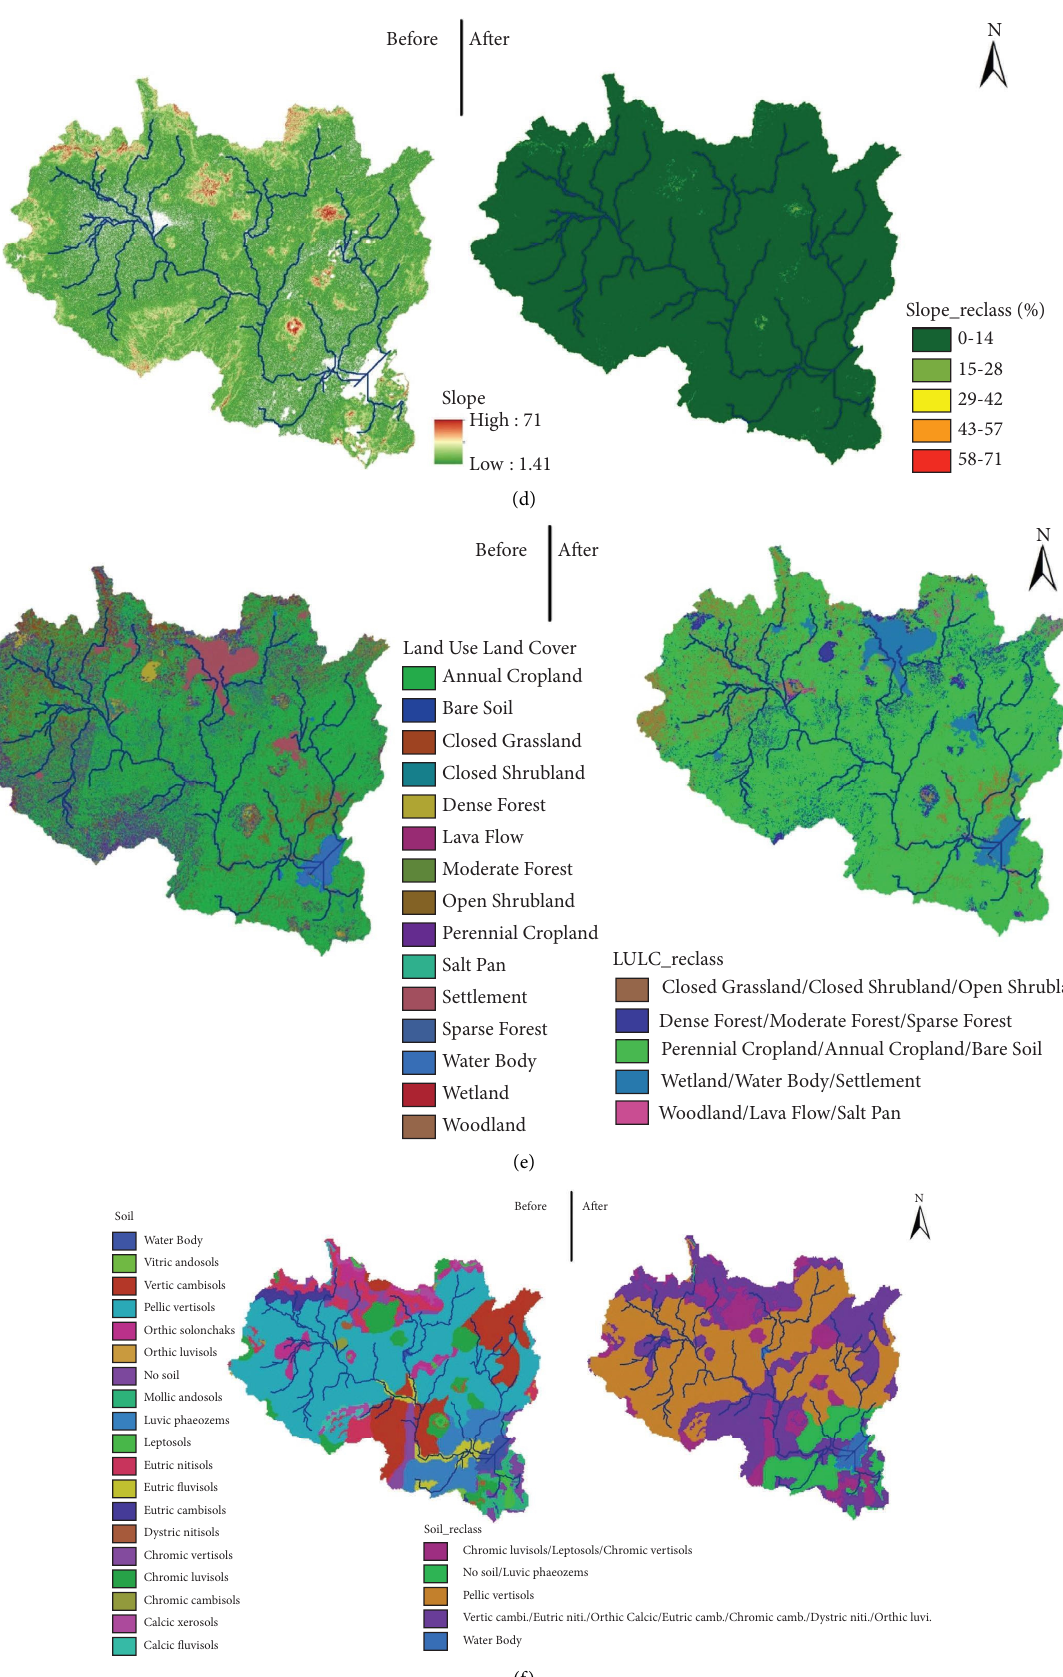
Figure 3: Classifcation of food-generating layers. (a) Elevation layer. (b) Rainfall layer. (c) Drainage density layer. (d) Slope layer. (e) Land use land cover layer. (f) Soil